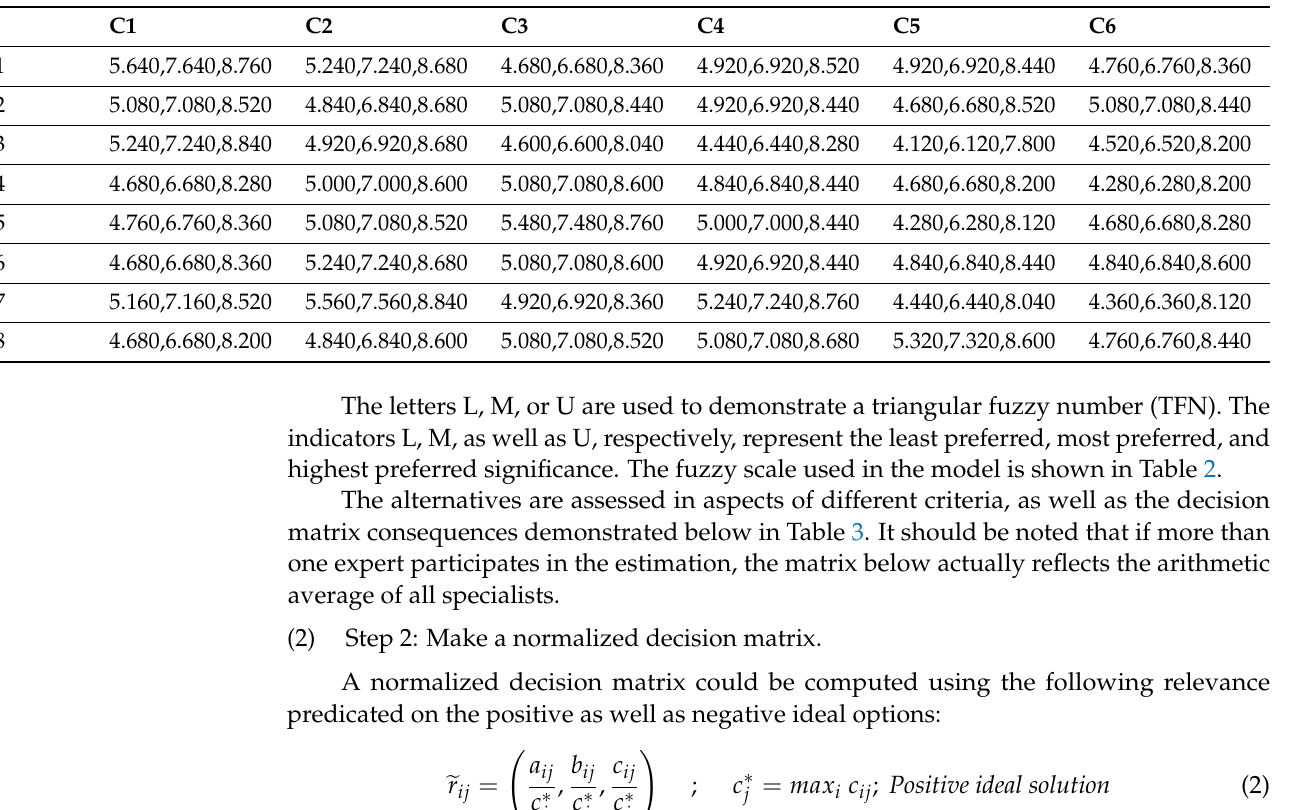
Table 3. Decision